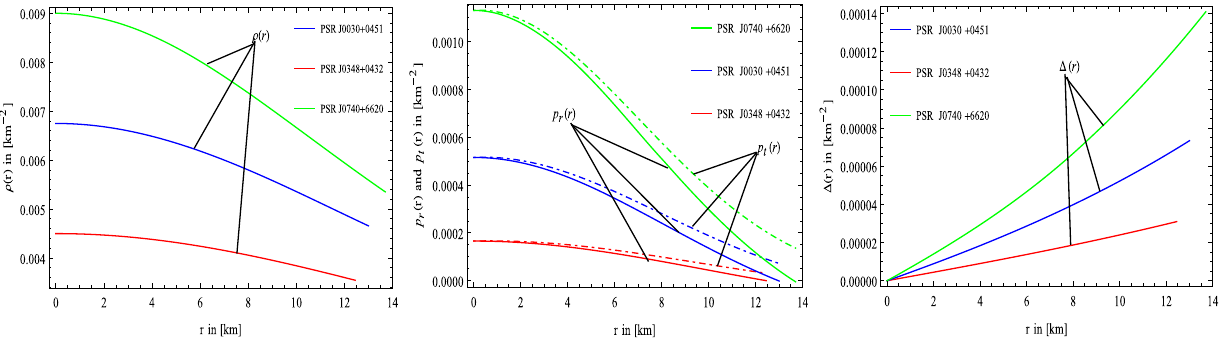
Fig. 1 Behaviour of the matter density ρ and the radial and transverse pressures ( p r , p t ) against the radial coordinate r of our stellar model for three heavy pulsars. For plotting these graphs, we use the numerical values of the constant parameters given in Table